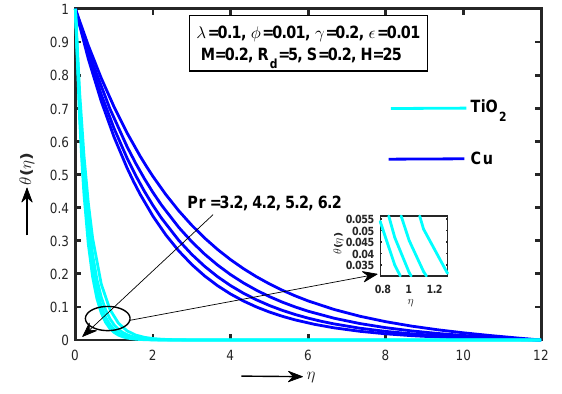
Figure 5: Significance of Pr on θ ( η )